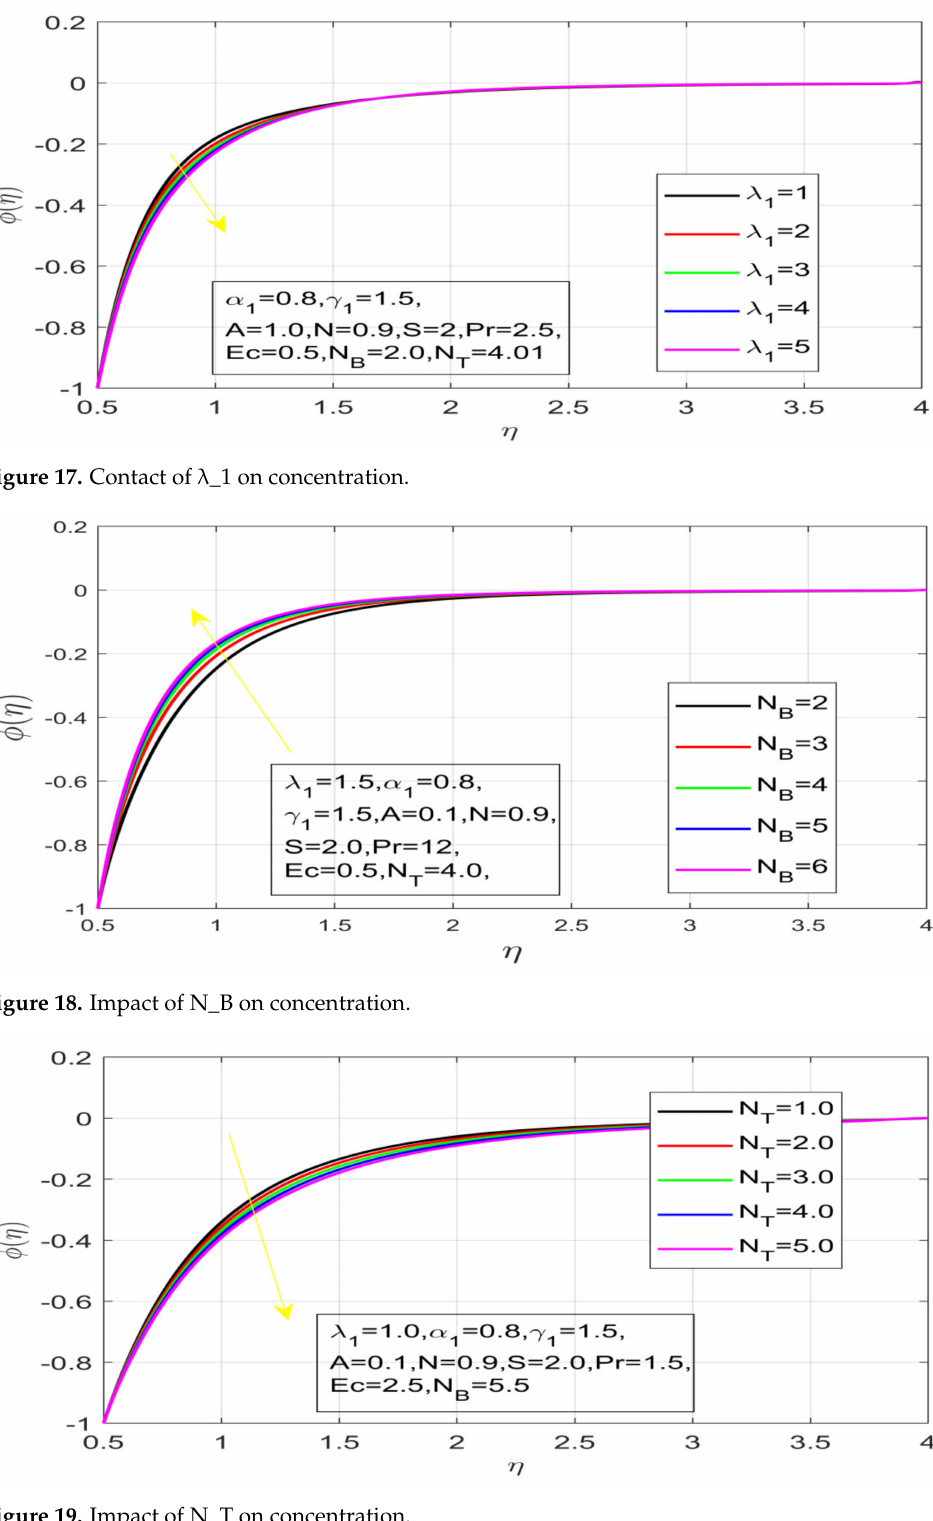
Figure 19. Impact of N_T on